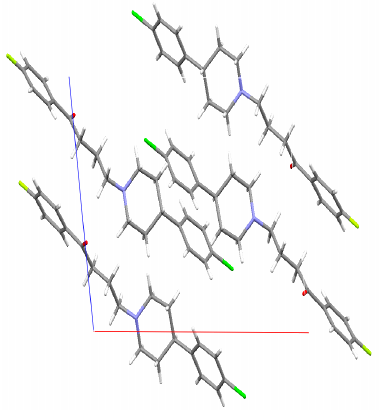
Figure 8. Crystal structure of deshydroxyhaloperidol in the unit cell. X-ray diffraction experiments were performed on single crystals with an Xcalibur 3 four-circle diffractometer (Oxford Diffraction). For details, see Supplementary Crystallographic Data.